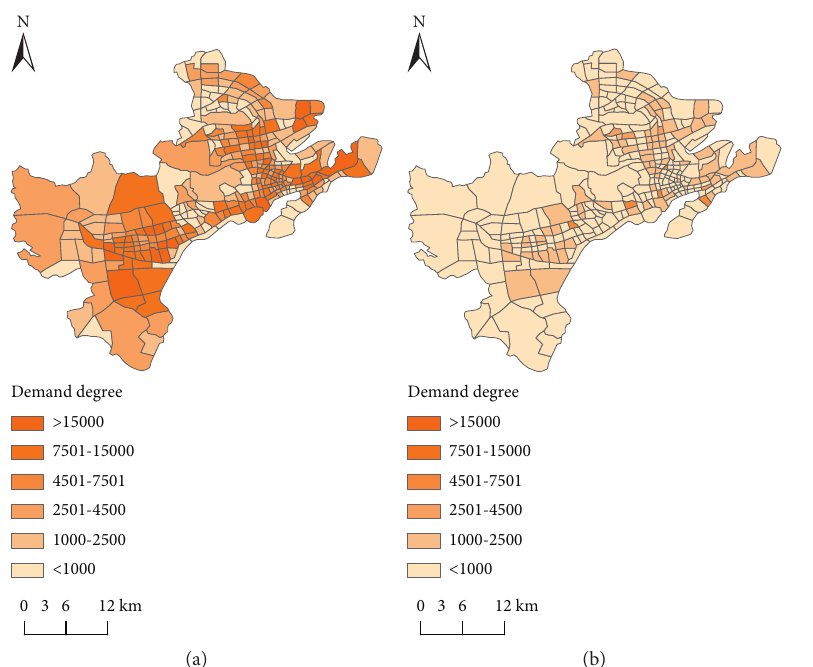
Figure 12: The different representations of degree for prehospital emergency care. (a) Demand degree is indicated by the number of living populations. (b) Demand degree is expressed in the SD3SFCA